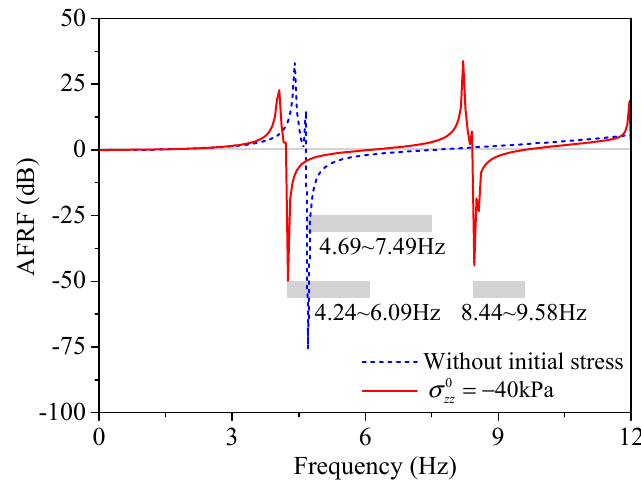
Figure 9. Average frequency response function (AFRFs) of the five-unit-cell periodic foundation under SV waves.